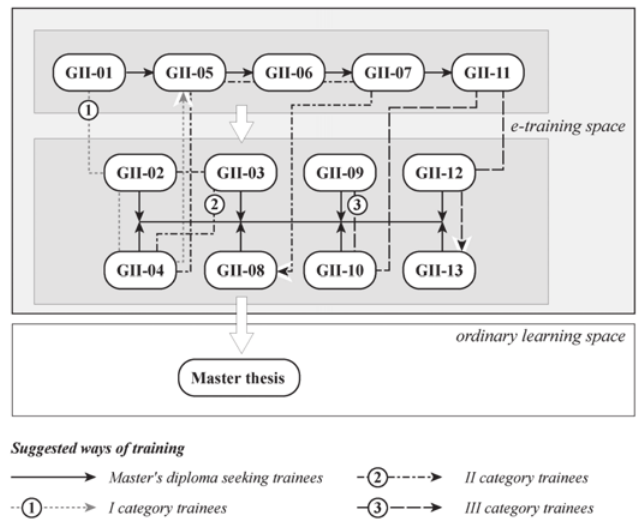
Fig. 2. Curriculum